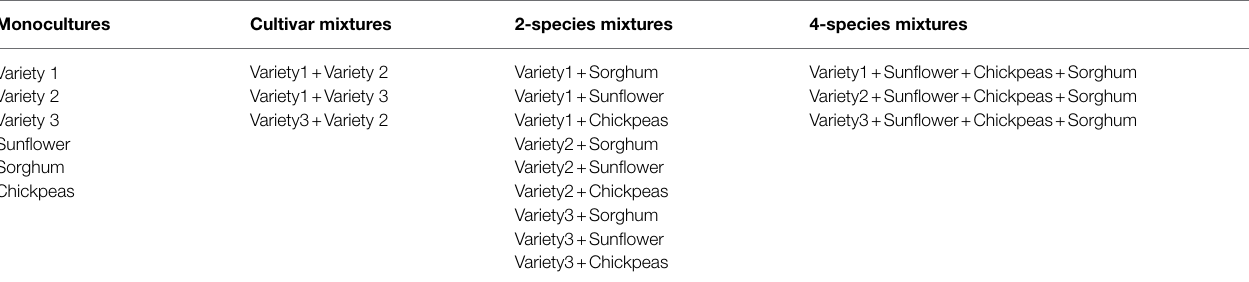
TABLE 1 | Different plant combinations applied in the